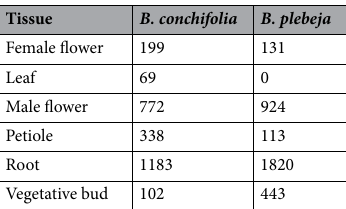
Table 3. Number of GO terms mapped to unigenes expressed uniquely in each tissue in B. conchifolia and B. plebeja